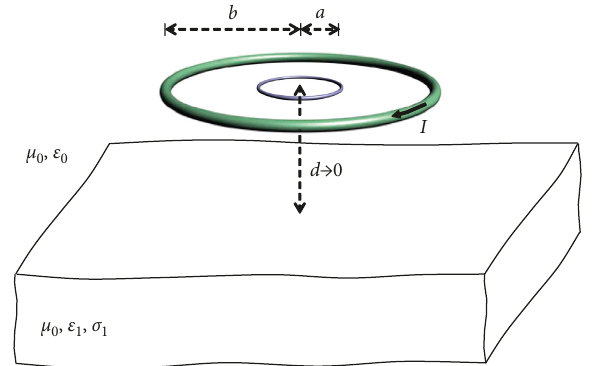
Figure 1: Two horizontal co-axial loops above a homogeneous